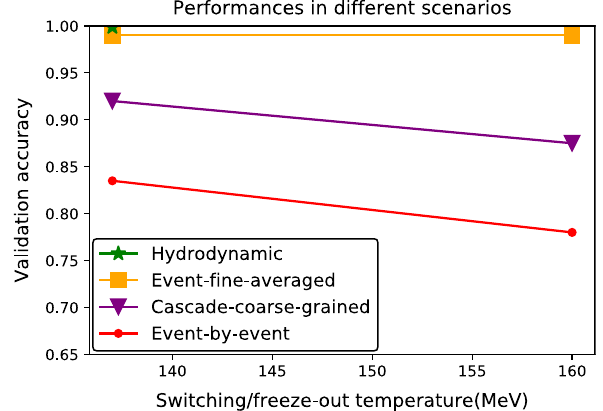
Fig. 3 Comparison between the validation accuracy in all the differ- ent sub-scenarios studied. The green star depicts the pure hydrody- namic result [39]. The orange square, the purple triangle and the red filled circle symbols depict the results for the 30-events-fine-averaged, cascade-coarse-grained and event-by-event spectra, respectively, in dif- ferent switching